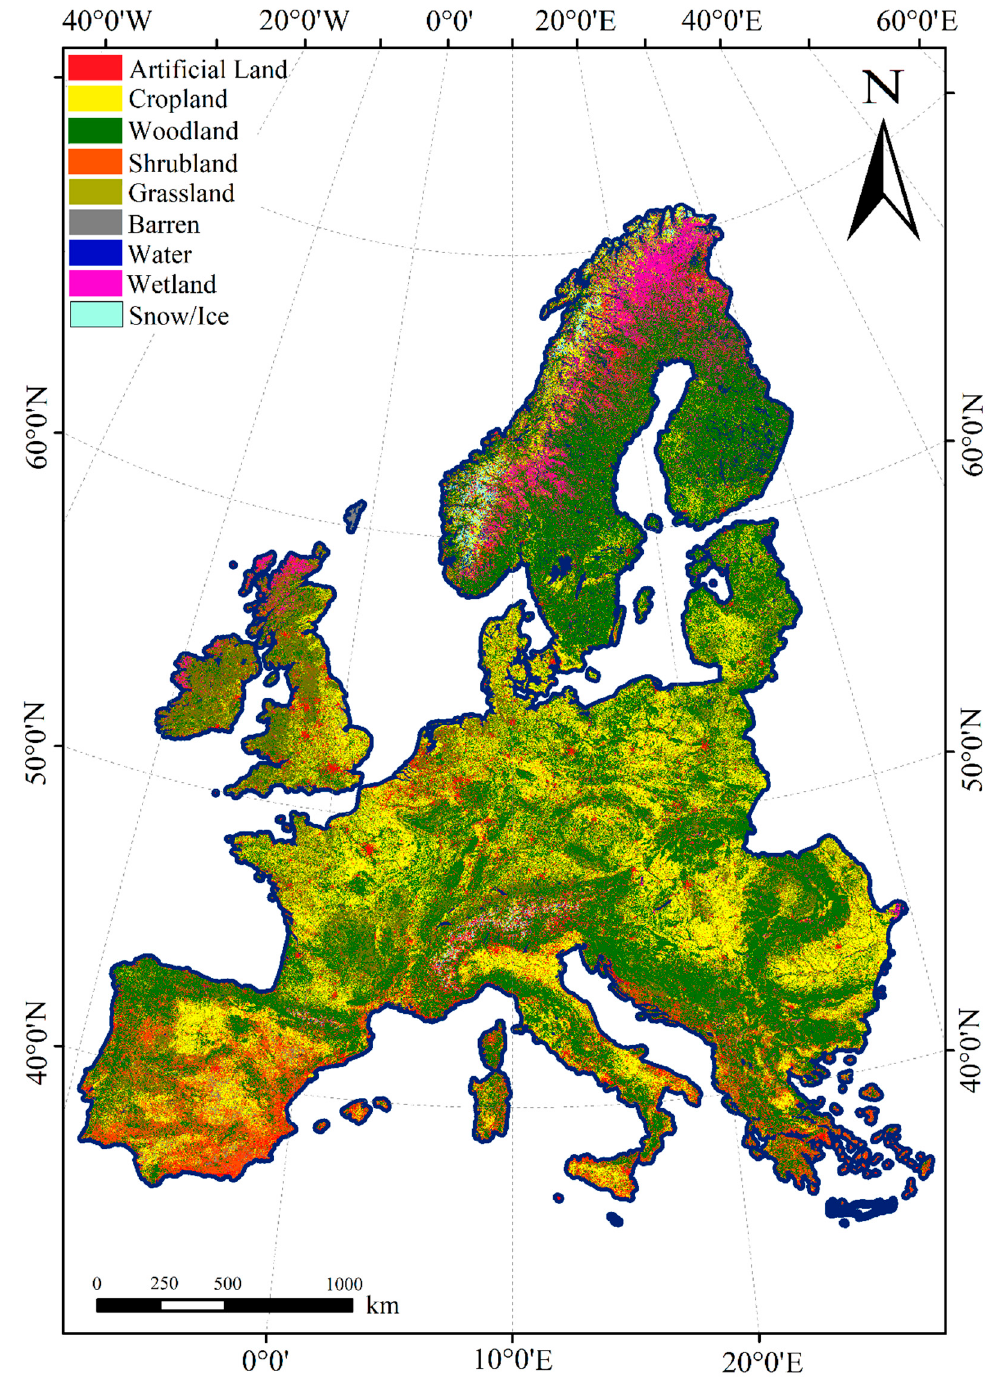
Figure 4. ELULC 10 of the year 2021 produced by an object-based SNIC model and ANN models in nine classes. nine